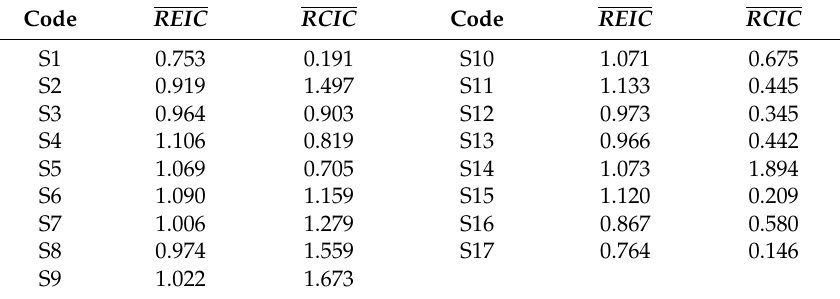
Table A4. (cid:1844)(cid:1831)(cid:1835)(cid:1829)(cid:3364)(cid:3364)(cid:3364)(cid:3364)(cid:3364)(cid:3364)(cid:3364) and (cid:1844)(cid:1829)(cid:1835)(cid:1829)(cid:3364)(cid:3364)(cid:3364)(cid:3364)(cid:3364)(cid:3364)(cid:3364) of China’s 30 regions in 2010.